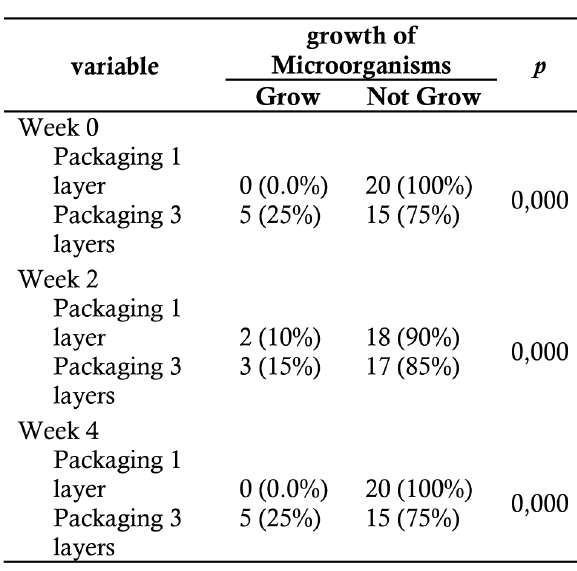
Duration of Storage and Growth Microorganisms